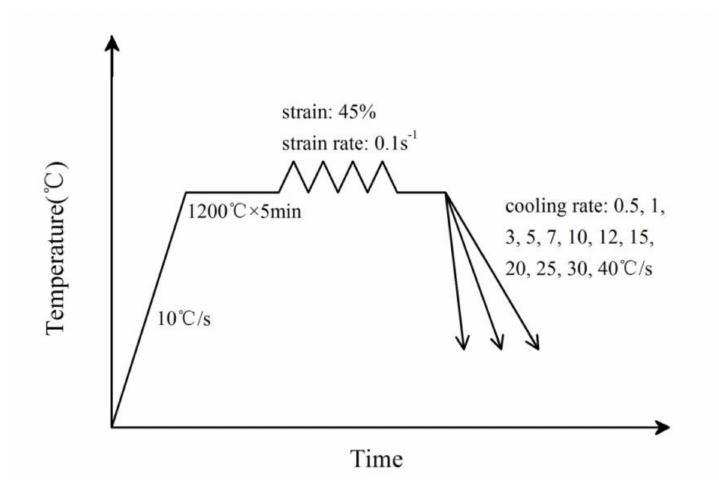
Figure 1. Schematic presentation of continuous cooling test